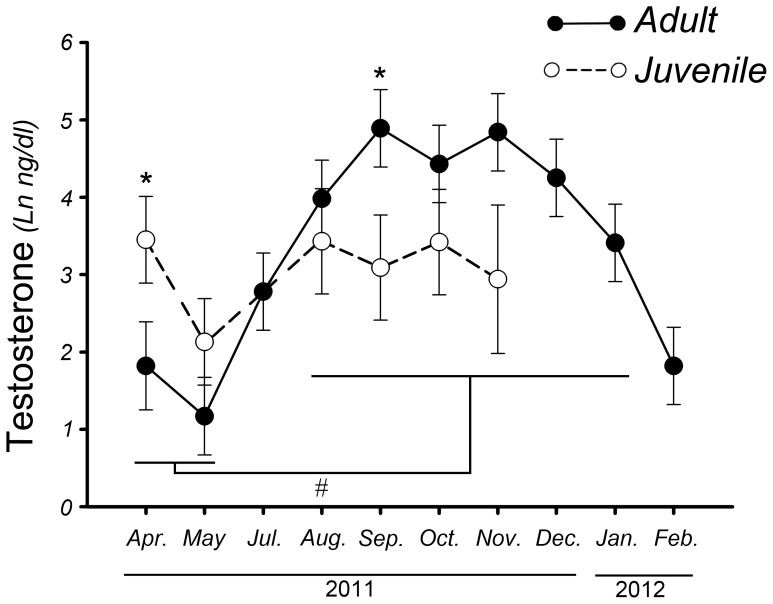
Annual changes in testosterone plasma levels of adult Greater Rhea males (solid line-filled circles) compared with juvenile rhea males (dashed line-empty circles), showing the differences between April and September (*).
# Shows differences between April-May and August-January in Greater Rhea adult males. Results are expressed as mean ± standard error. Adult males n = 6, juvenile males (April n = 3) and (September n = 2); * and # denote p<0.01.